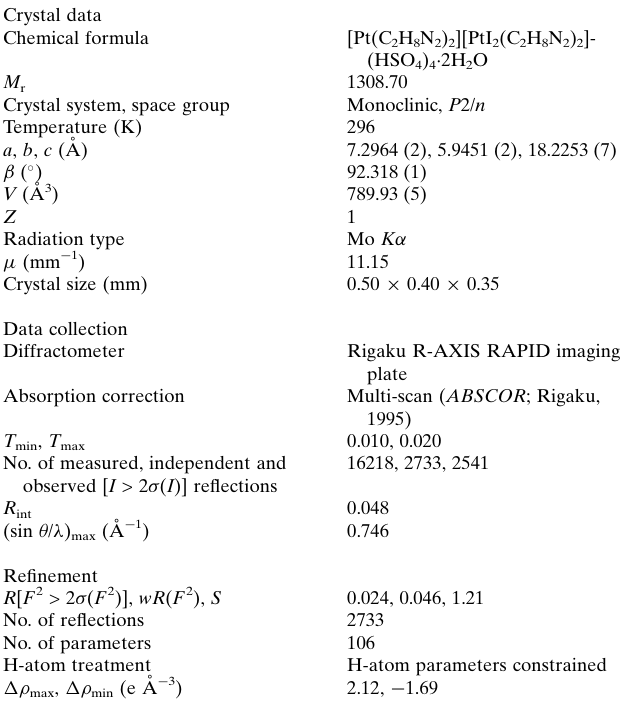
Table 3 Experimental details. Crystal data Chemical